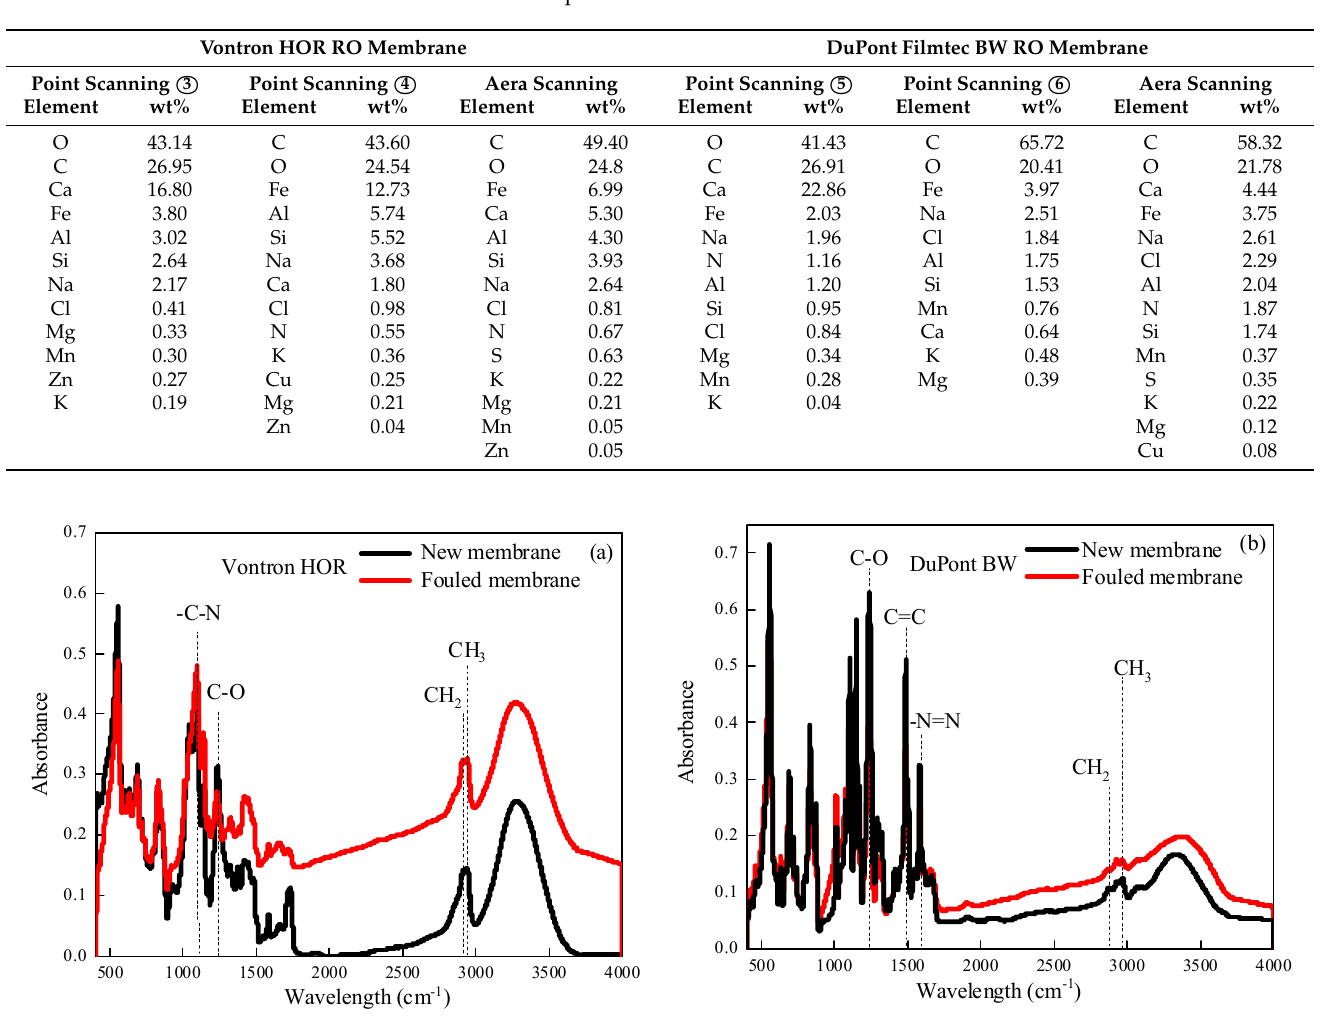
Figure 6. ATR-FTIR spectra of new and fouled Vontron HOR ( a ) and DuPont Filmtec BW ( b ) RO membrane after 3 batch fi ltrations.